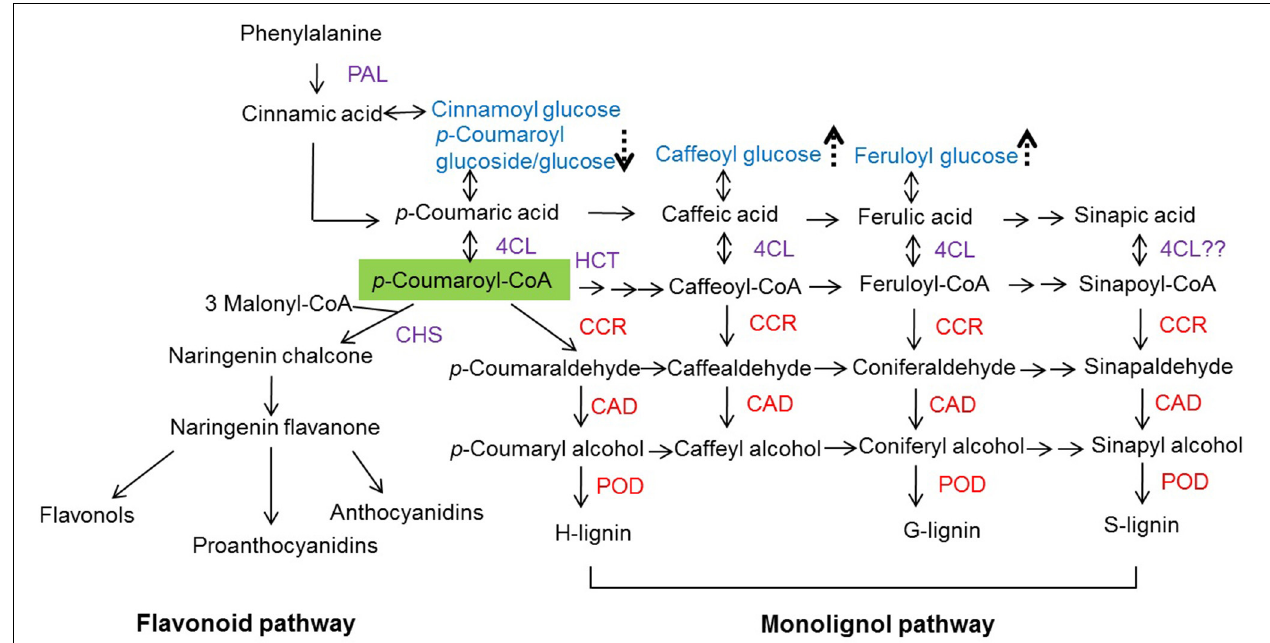
FIGURE 1 | Flavonoid and monolignol biosynthetic pathways. PAL, phenylalanine ammonia lyase; 4CL, 4-coumaroyl-CoA ligase; CHS, chalcone synthase; HCT, hydroxycinnamoyl transferase; CCR, cinnamoyl-CoA reductase; CAD, cinnamyl alcohol dehydrogenase; POD, peroxidase. Arrow with dashed lines indicate compounds are up- ( ) or down-regulated ( )